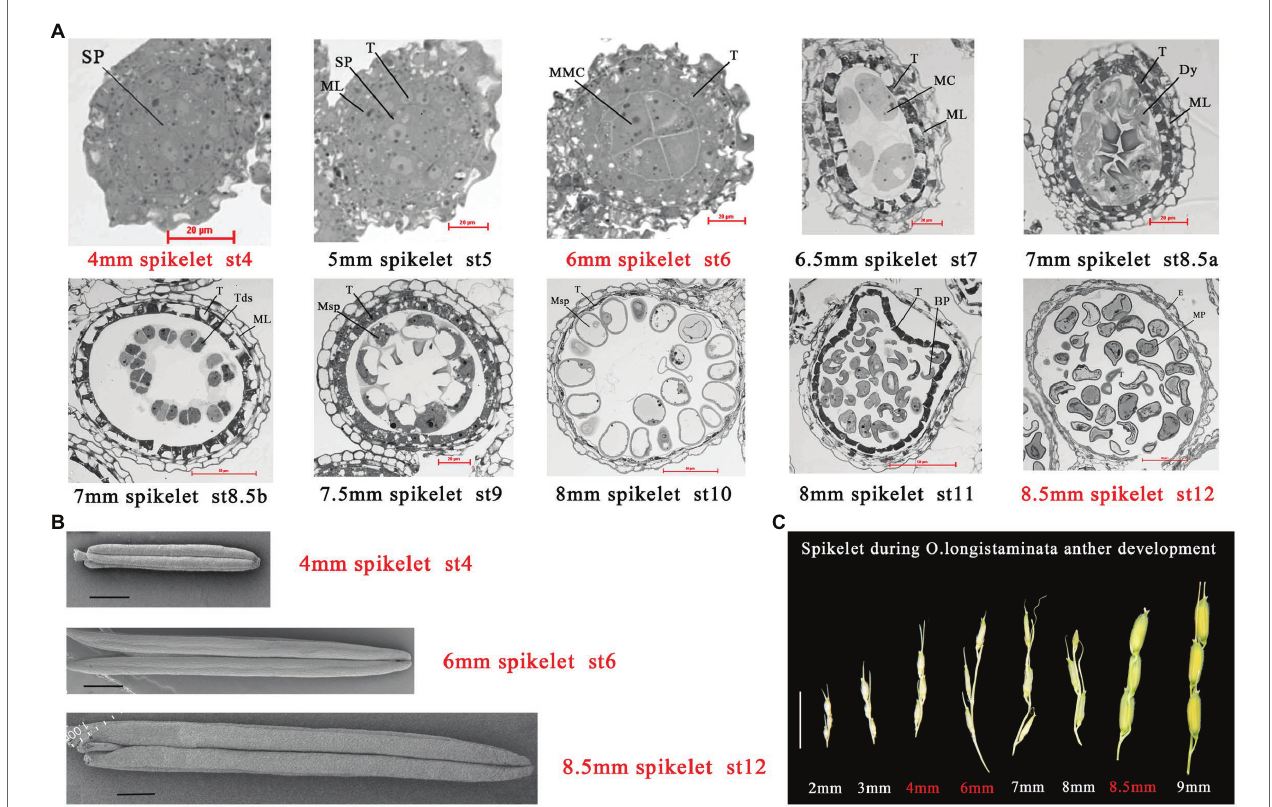
FIGURE 1 | Characterization of male fertility in Oryza longistaminata . (A) Semi-thin sections of anthers from O. longistaminata at different developmental stages. Bars = 20 or 50 μm. Sp, sporogenous cell; T, tapetum; Tds, tetrads; Dy, dyad cell; E, epidermis; MC, meiotic cell; ML, middle layer; MMC, microspore mother cell; MP, mature pollen; Msp, microspore parietal cell; BP, bicellular pollen; Bars = 20 or 50 μm (B) Scanning electron microscope observation of anther at different developmental stages in O. longistaminata . Bars = 1 mm. (C) Panicle phenotypes of O. longistaminata at different developmental stages. Bars = 1